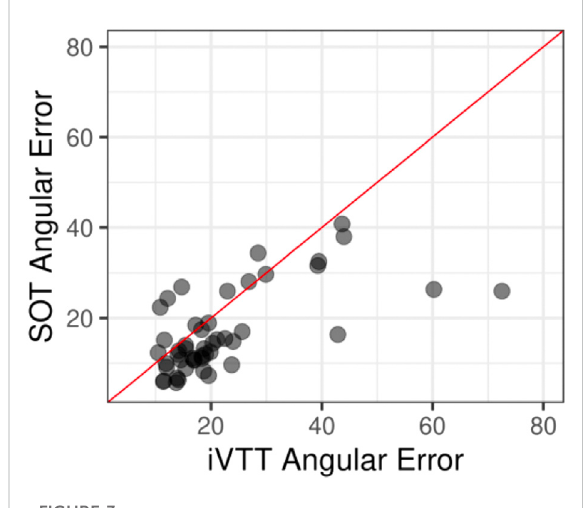
FIGURE 3 Ascatterplotfortheindividualaverageabsoluteangularerror for the immersive viewpoint transformation task (iVTT) and average absolute angular error for the spatial orientation task (SOT). When points fall on the red line, the corresponding participants have the exactly same average errors for both tasks. Most points are below the red line, indicating that most people have poorer performance on the iVTT task.